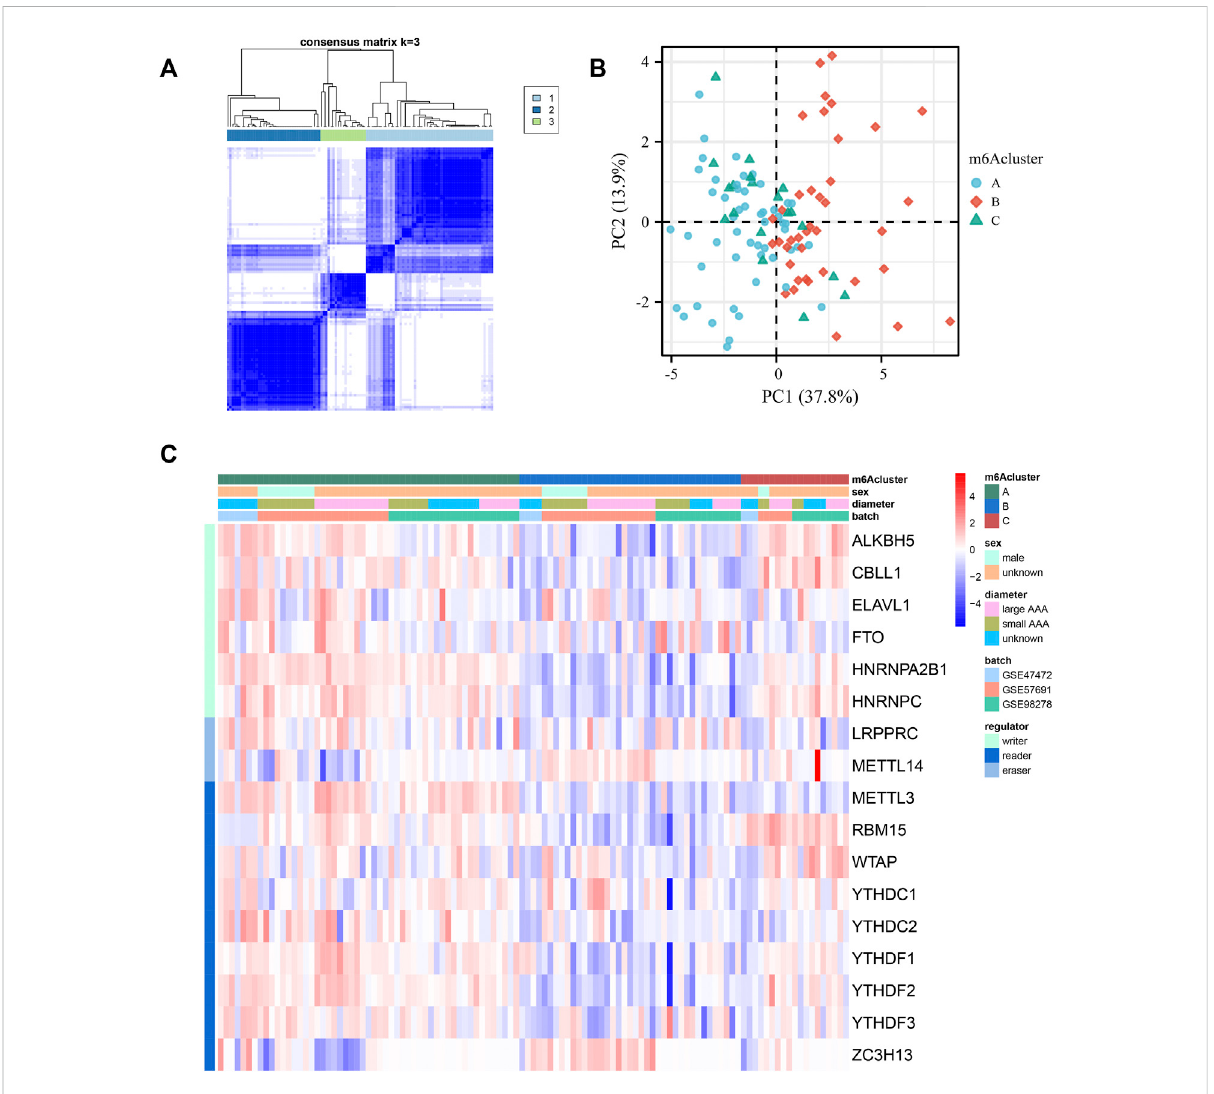
FIGURE 4 Identi fi cation of three m6A methylation patterns based on 17 regulators. (A) Consensus clustering of the 17 m6A methylation regulators matrix fork=3of111patientsintheGEOcohort(GSE98278,GSE47472andGSE57691). (B) Theprincipalcomponentanalysisoftranscriptionalpro fi leofthe m6A methylation genes of the patients in GEO cohort. (C) Unsupervised clustering of the methylation regulators. m6Acluster, sex, AAA diameter, batch, and methylation modi fi cation types are used for annotations. Red: high expression. Blue: low